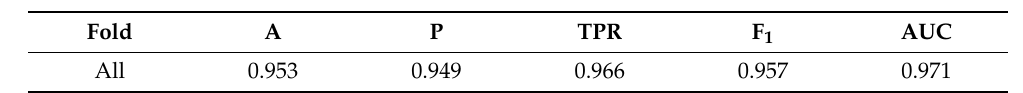
Table 4. Performance on verification data